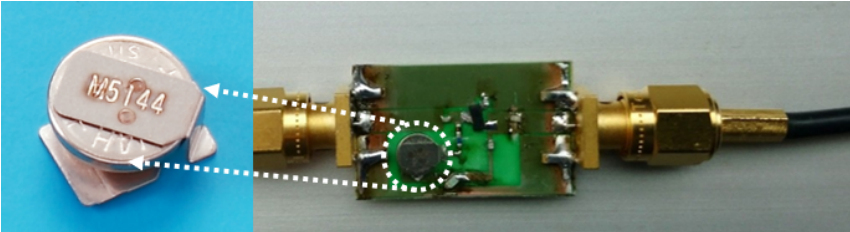
Figure 7. The implemented biasing circuit besides the utilized battery.